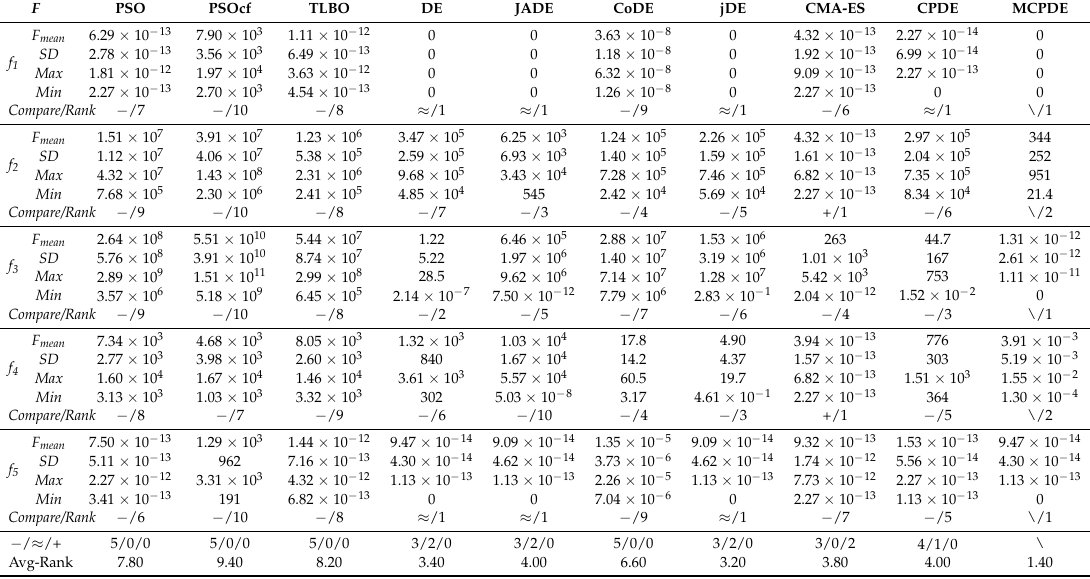
Table 2. Experimental results of PSO, PSOcf, TLBO, DE, JADE, CoDE, jDE, CMA-ES, CPDE and MCPDE over 30 independent runs on f 1 – f 5 test functions with 30 D . F PSO PSOcf F mean 6.29 × 10 − f 1